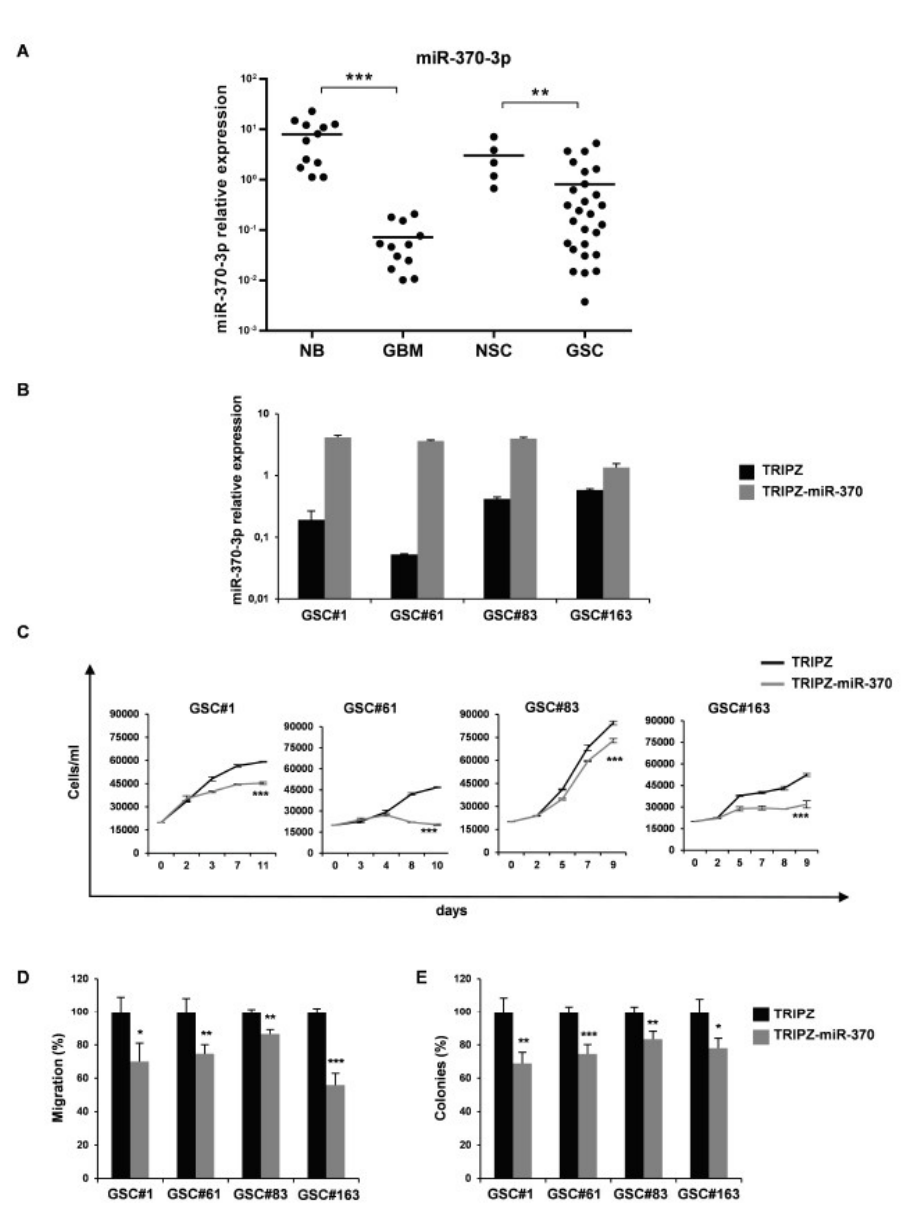
Figure 1. miR-370-3p is down-regulated in Glioblastoma (GBM) tissues and Glioblastoma Stem-like Cell (GSC) lines and its restoration reduces cell growth, migration and clonogenic abilities of GSCs. ( A ) Real time RT-PCR analysis of miR-370-3p expression performed on normal brain tissue samples (NB, n = 12), GBM tissues (GBM, n = 12), NSCs ( n = 5) and GSCs ( n = 27). Samples were run in duplicate and normalized with Glyceraldehyde-3-Phosphate Dehydrodenase (GAPDH). * p < 0.05; ** p < 0.01; *** p < 0.001. ( B ) Real time PCR analysis of miR-370-3p expression in GSC#1, #61, #83 and #163 transduced with either TRIPZ or TRIPZ-miR-370 inducible vectors. ( C ) Growth curves of GSCs transduced with either TRIPZ or TRIPZ-miR-370 vector. Points and range lines at each day represent mean and SD of at least two independent experiments in triplicate. Two-way analysis of variance for repeated measures was performed on the whole set of data. ( D ) Analysis of migration efficiency in GSCs transduced with TRIPZ-miR-370 vector 48 h after induction. Values are reported as percentage relative to control vector and shown as mean ± SD from two independent experiments in triplicate. (E) Analysis of efficiency in colony formation of GSCs after transduction with TRIPZ-miR-370 vector. Percent colony number values from two independent experiments in triplicate were calculated over the correspondent empty vector and are shown as mean ± SD for each GSC